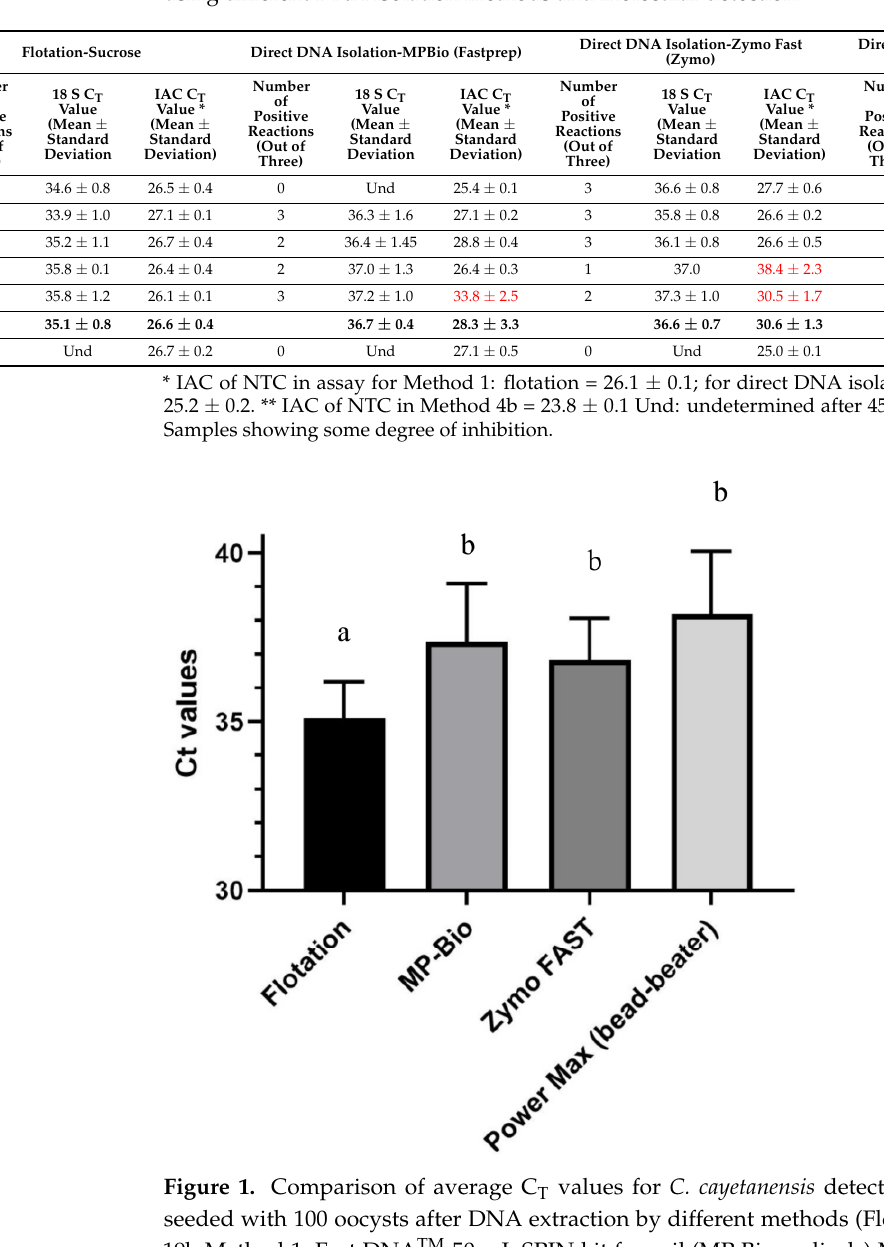
Table 2. qPCR detection data (number of positive qPCR replicates, individual C T values for C. cayetanensis and IAC for each sample) in samples of soil (10 g) seeded with 100 C. cayetanensis oocysts using different DNA isolation methods and molecular detection.